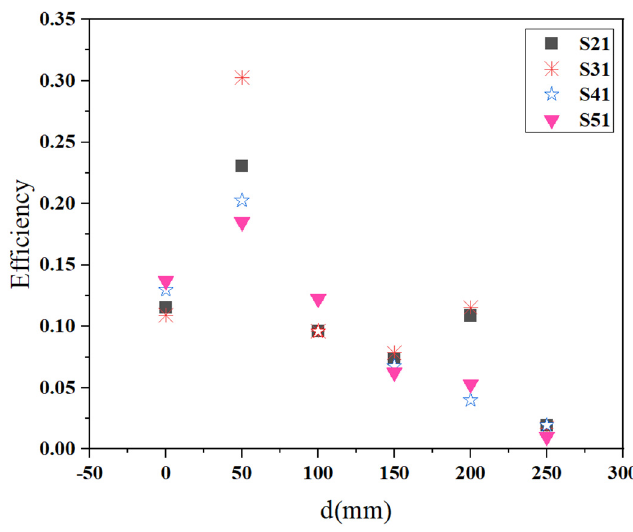
Figure 5. Comparison of the efficiency of the STFR system in different adjacent Rx coils.